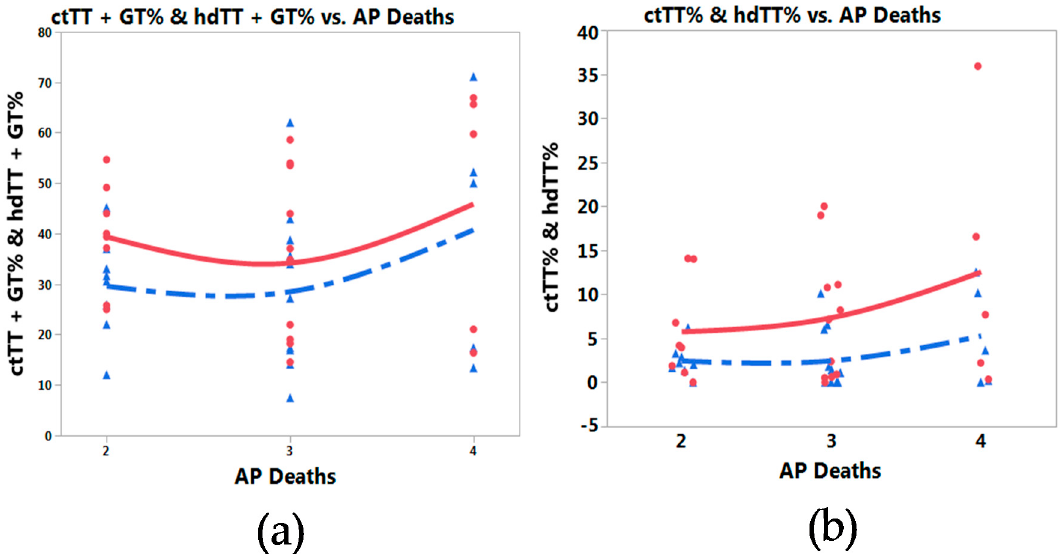
Figure 4. Nonlinear fit of NOS3 G894T polymorphisms with death from air pollution bi ‐ variate plots for countries with pooled RR > 2: ( a ) TT plus GT polymorphisms, ( b ) TT only (AP death: Death rates from air pollution, Levels per million: 2 = 51–100, 3 = 101–250, 4 = 251–400 and greater); case = red (solid line), control = blue (dotted line).